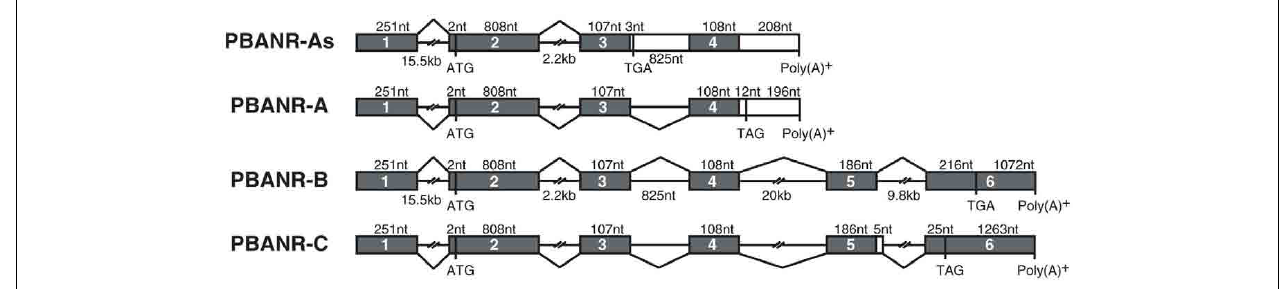
FIGURE 2 | Schematic diagram of the B. mori PBANR genomic structure and alternative splice sites. The four BommoPBANR variants (As, A, B, and C) are depicted.The filled boxes represent exons. Initiation (ATG) and stop sites (TGA orTAG) are indicated by their respective codons.